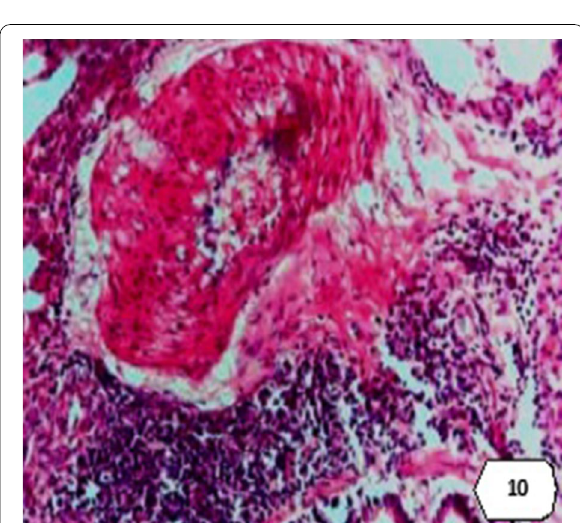
Fig. 10 Lung tissue image of INDOX-administered animals showing the proliferation of fibrous tissue bundles around lung capillaries and interstitial tissues associated with inflammatory cells (star) (hematoxylin and eosin 400 ×